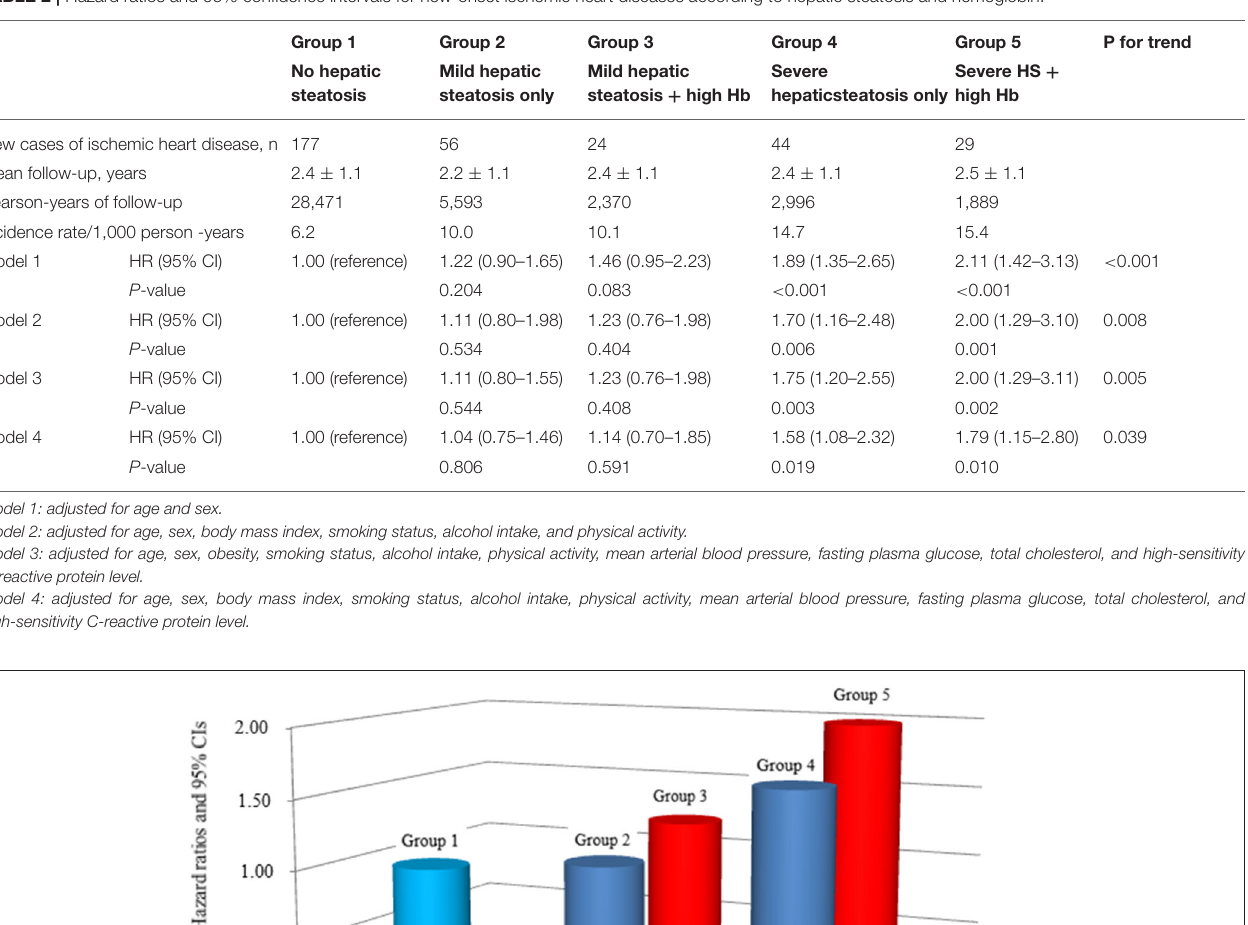
TABLE 2 | Hazard ratios and 95% confidence intervals for new-onset ischemic heart diseases according to hepatic steatosis and hemoglobin.